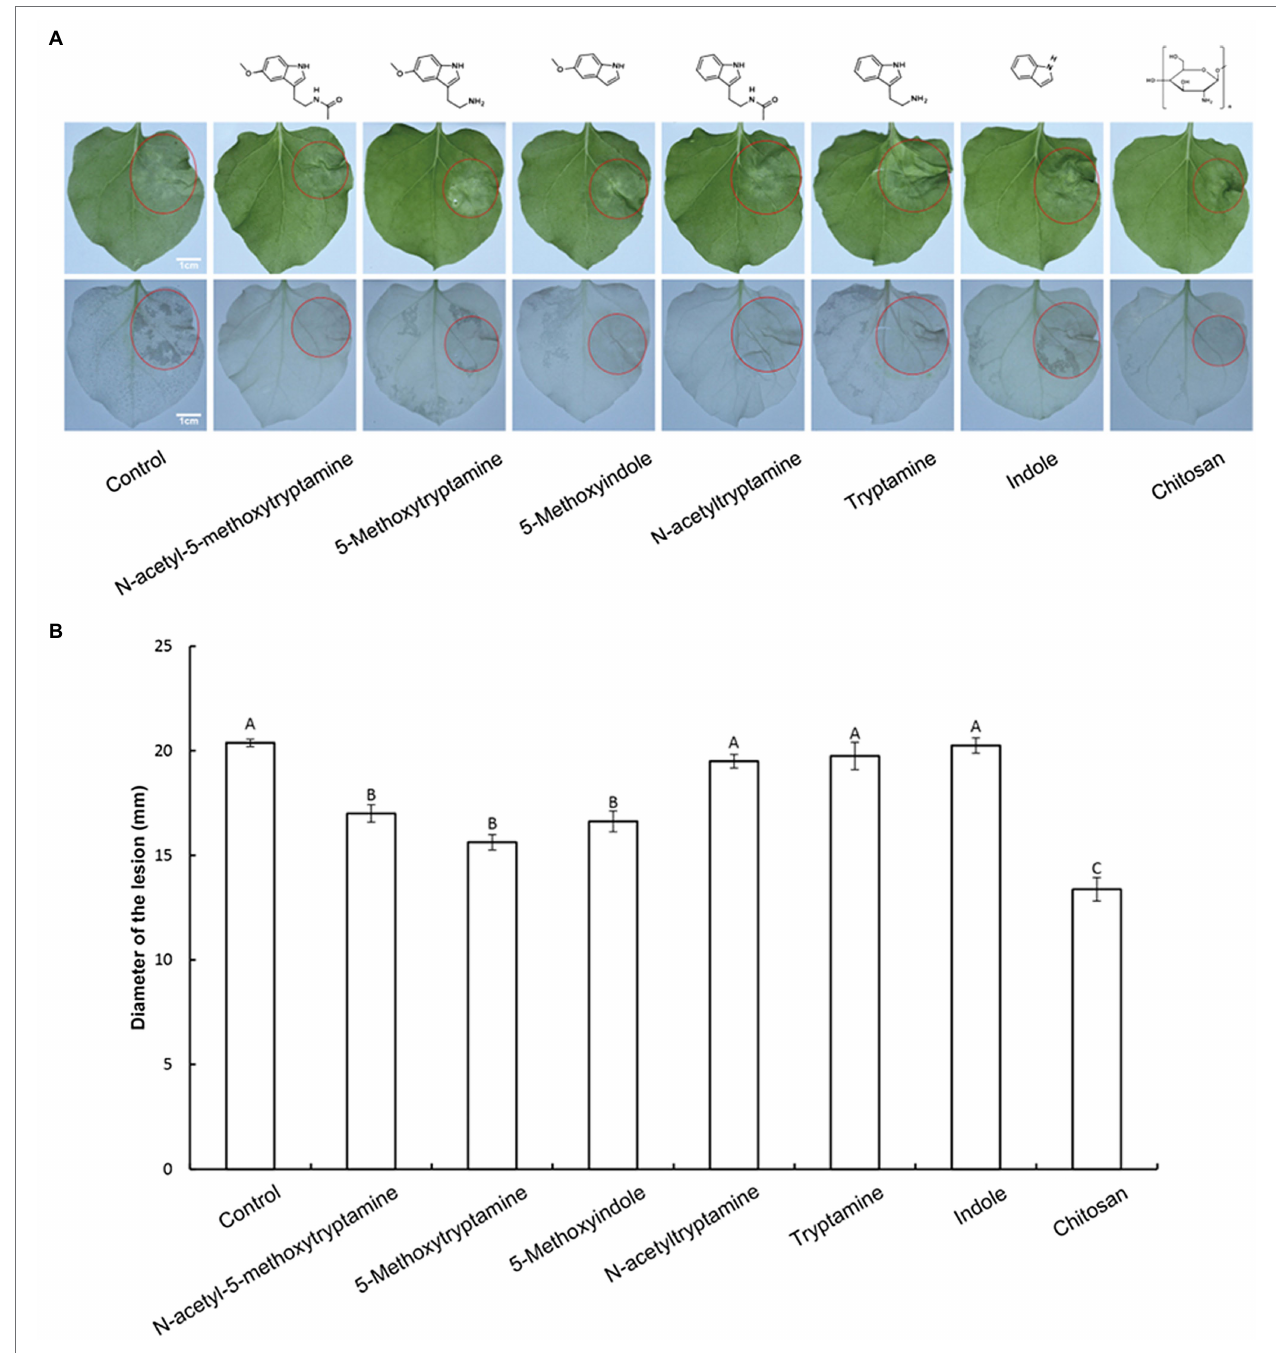
FIGURE 1 | Effect of melatonin and its homologs on disease severity in N. benthamiana caused by P. nicotianae . (A) Disease symptoms in N. benthamiana leaves following pretreatment with 50 μ M solutions of MT and MT-homologs and inoculate with P. nicotianae. Fully expanded N. benthamiana leaves were detached from plants 4 h after being watered with the test compounds. The leaves were placed in Petri dishes containing water-saturated filter paper and then inoculated with P. nicotianae . Photographs of the lesions were taken at 48 h post-inoculation. Water (control) was used as a negative control and chitosan was used as positive control. Ethanol-bleached N. benthamiana leaves were also photographed to more clearly illustrate the region of dead cells. (B) Average lesion diameter (red circles) in N. benthamiana leaves treated with different test compounds. Data represent the mean ± standard deviations (SDs) of three replicates (experiments). Columns with different letters indicate significant differences in lesion size as determined by a Duncan’s multiple range